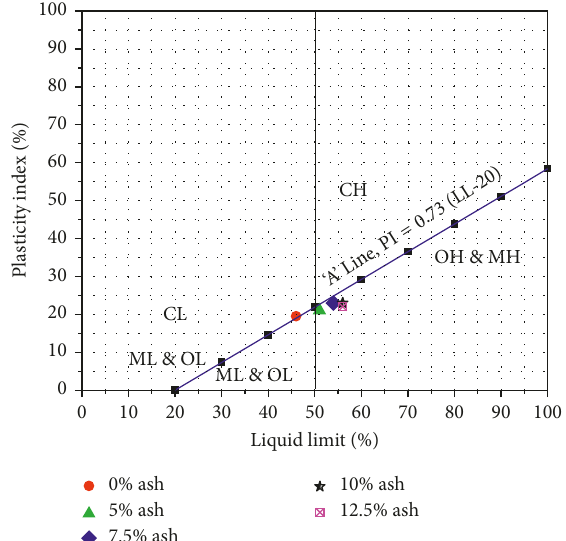
Figure 1: Plasticity chart showing the original and wood ash- treated soil.